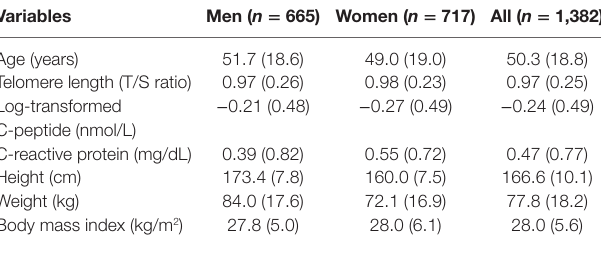
TaBle 1 | Basic characteristics of study